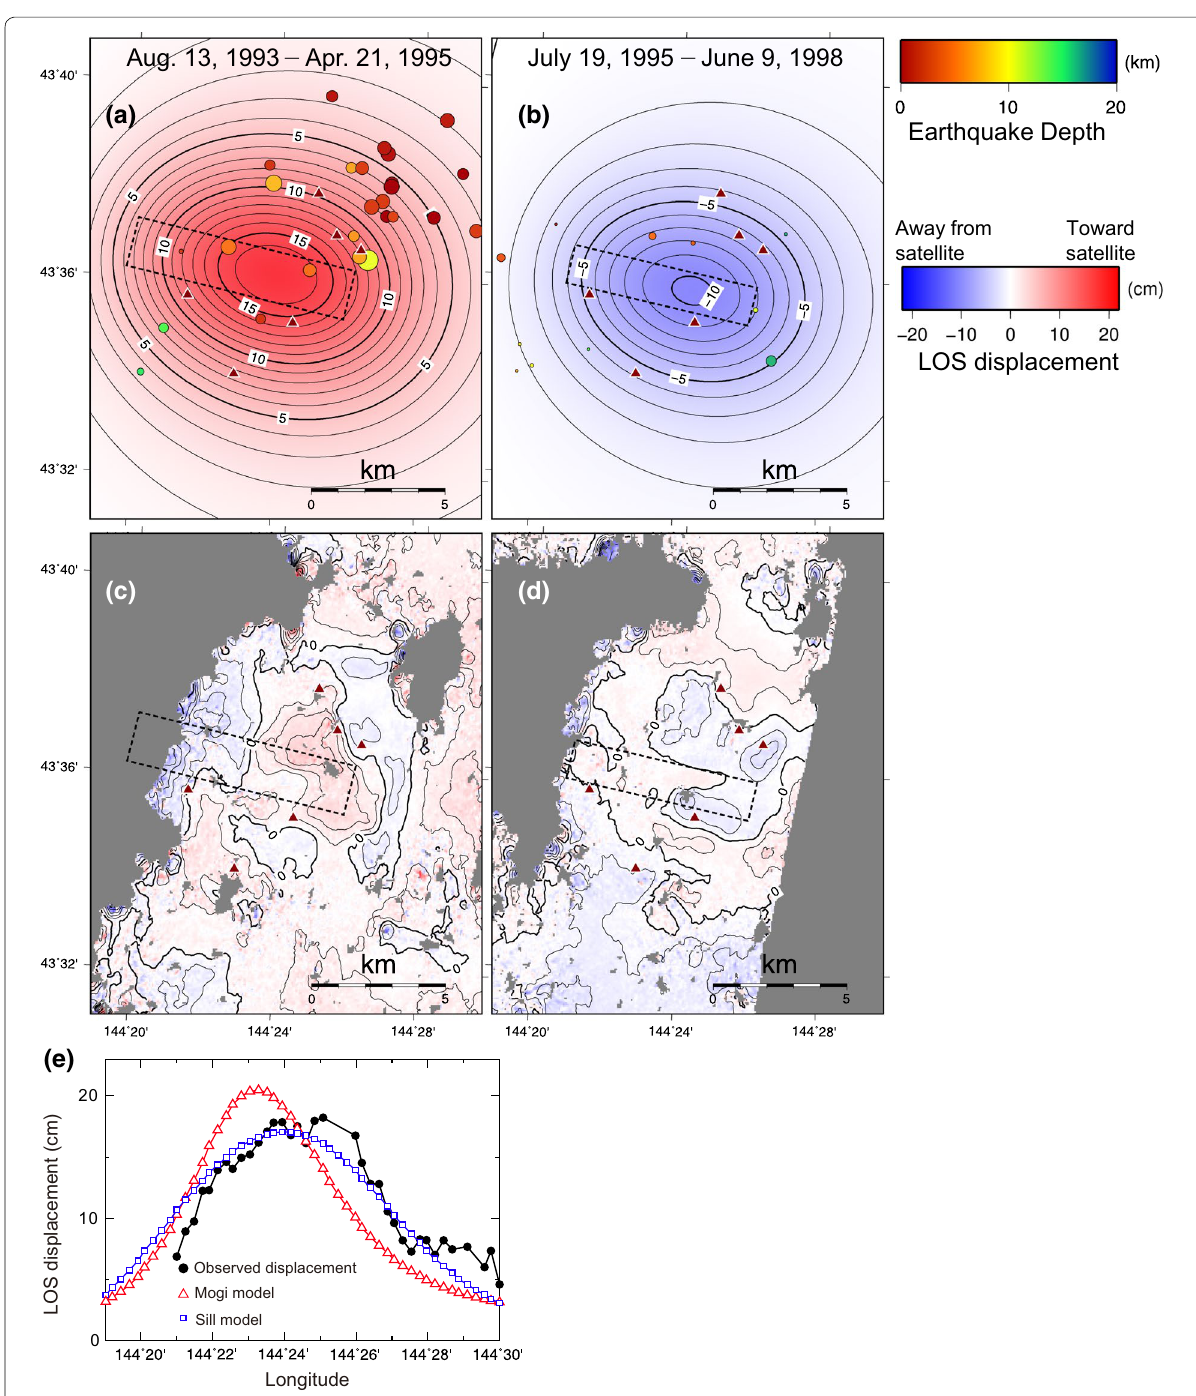
Fig. 4 a A synthesized interferogram based on the best-fit sill model for InSAR pair 2 (uplift). Small circles indicate hypocenters during the period of the InSAR pair (after Earthquake Research Institute 2002). Rectangle with black dashed line indicates the sill in Table 2. b A synthesized interferogram based on the best-fit sill model for InSAR pair 8 (subsidence). Small circles indicate hypocenters during the period of the InSAR pair (after Earthquake Research Institute 2002). Rectangle with black dashed line indicates the sill in Table 2. c Residual interferogram of the observation and the sill model ( a ). Rectangle with black dashed line indicates the sill in Table 2. d Residual interferogram of the observation and the sill model ( b ). Rectangle with black dashed line indicates the sill in Table 2. e Comparison of the LOS displacement profiles along 43°36 ′ N between the observation and two best- fit model simulations assuming either a spherical source or a sill in Table 2 for the InSAR pair 2